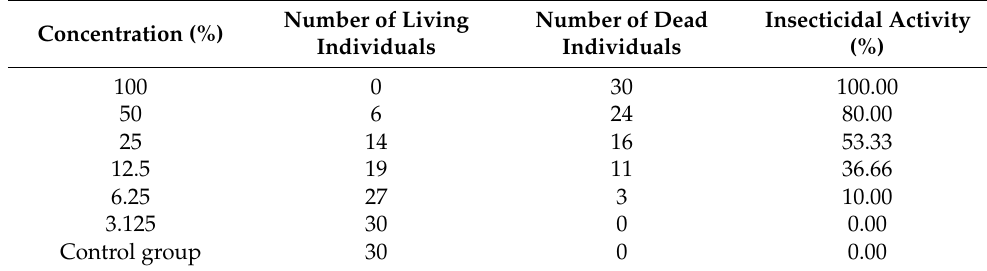
Table 7. Insecticidal activity of CSEO.